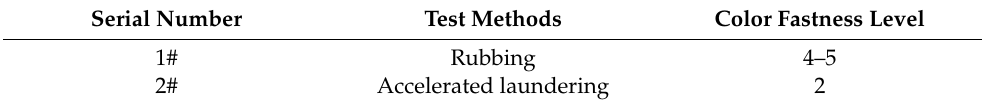
Table 3. Effect of different test methods on color fastness of functional cotton